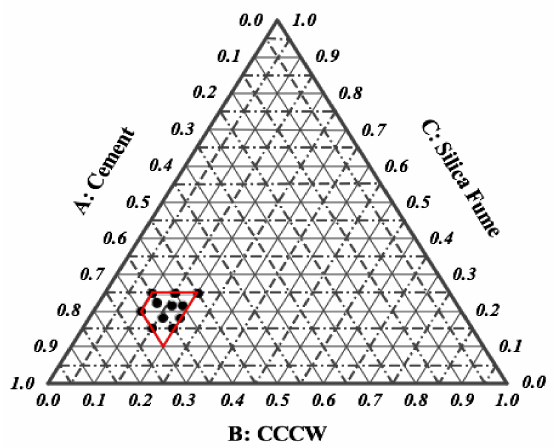
Figure 10. Spectral points of optimal mixture design.